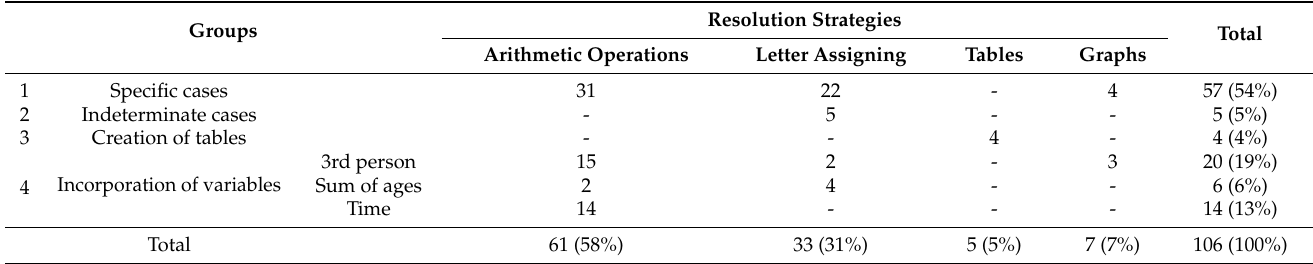
Table 2. Tasks and types of solutions in case